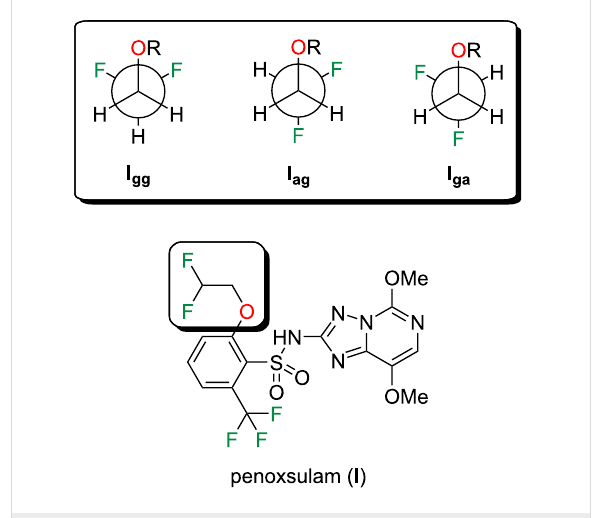
Figure 1: Chemical structure of penoxsulam ( I ) and the main stag- gered conformations along the two F–C–C–O torsional angles (i.e., I gg , I ag , and I ga ; g = gauche and a = anti